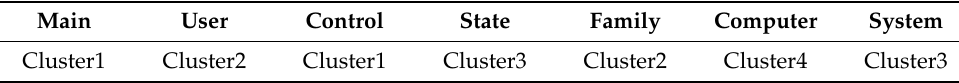
Table 4. Clustering